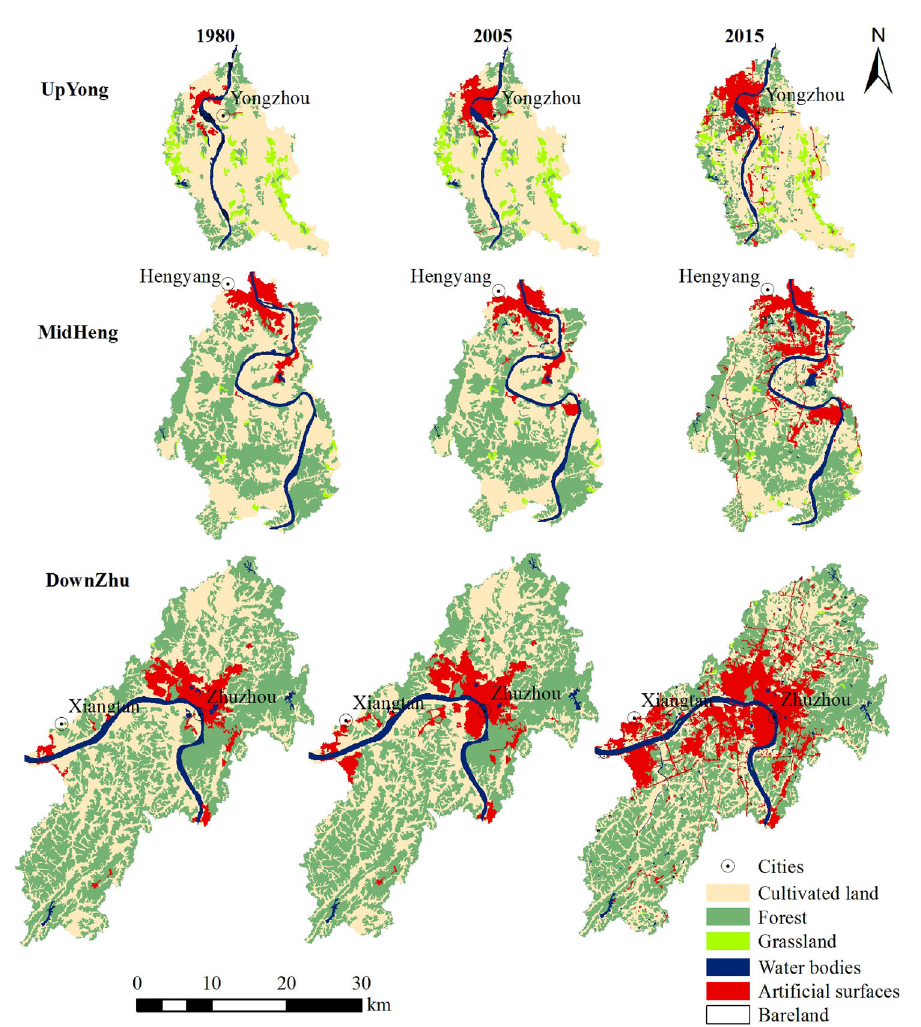
Fig. 3 LULC changes in the UpYong, MidHeng and DownZhu catchments from the 1980s to 2015 Table 4 Responses of the peak flood flow and flood volume to land use changes and urbanization in the UpYong, MidHeng, and DownZhu catchments of the Xiang River Basin Catchments Land use conditions Impervious ratio (%) Curve number Q p Ra_p